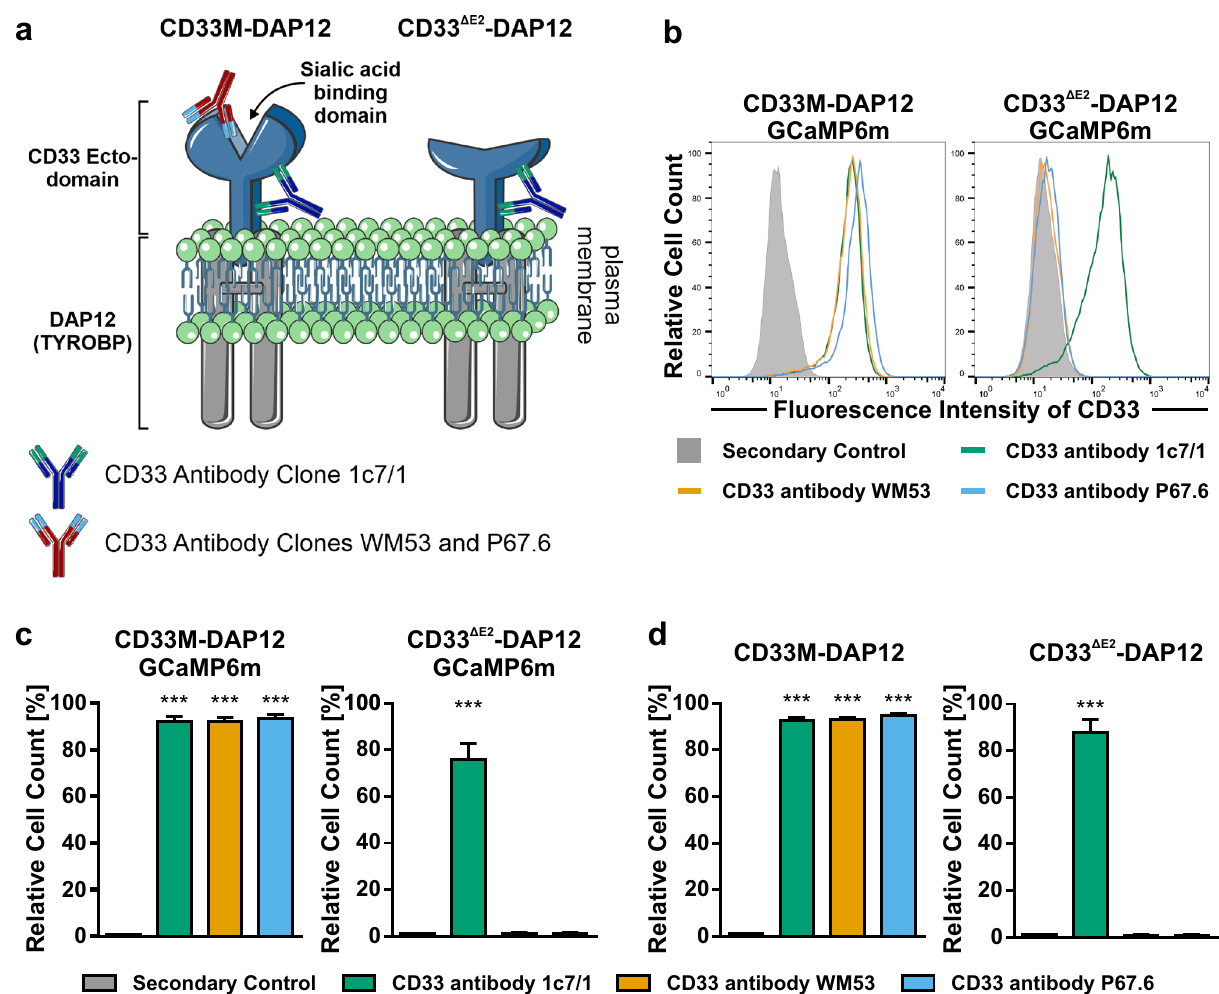
Figure 2. Flow cytometric analysis of CD33 surface expression. ( a ) Schematic drawing of the CD33-DAP12 constructs. Both, the full CD33 ecto-domain (CD33M) and the ecto-domain lacking the sialic acid binding domain (CD33 ∆E2 ) were fused to TYROBP/DAP12. CD33 ∆E2 can be identified by binding of the antibody clone 1c7/1 (blue) but not WM53 or P67.6 (red), whereas all three antibody clones can bind CD33M. ( b ) The CD33- DAP12 and CD33-DAP12-GCaMP6m cells were stained for CD33 surface expression with the antibody clones 1c7/1, WM53 and P67.6. A representative flow cytometry histogram plot for the CD33M-DAP12-GCaMP6m cells is shown (left side). All three tested antibodies were able to stain full-length CD33 on the cell surface. Expression of variant 2 CD33 from CD33 ∆E2 -DAP12 and CD33 ∆E2 -DAP12-GCaMP6m cells was only detected by antibody clone 1c7/1. A representative flow cytometry histogram plot for the CD33 ∆E2 -DAP12-GCaMP6m cells is shown (right side). ( c ) Quantification of CD33 staining showed a high percentage of CD33 expressing cells in the CD33M-DAP12-GCaMP6m line for all three tested antibody clones but only the CD33 antibody clone 1c7/1 was able to detect CD33 in CD33 ∆E2 -DAP12-GCaMP6m expressing cells. The antibody clones WM53 and P67.6 did not show any staining of CD33 ∆E2 -DAP12 expressing cells. ( d ) Quantification of CD33 staining revealed a high percentage of cells in the CD33M-DAP12 line expressed CD33, and was detected by all three antibody clones. CD33 in CD33 ΔE2 -DAP12 expressing cells was only detected by antibody clone 1c7/1. Data are shown as mean + SEM of three to five independent experiments; *** p ≤ 0.001 compared to Secondary Control determined by Welch ANOVA followed by Games-Howell post hoc